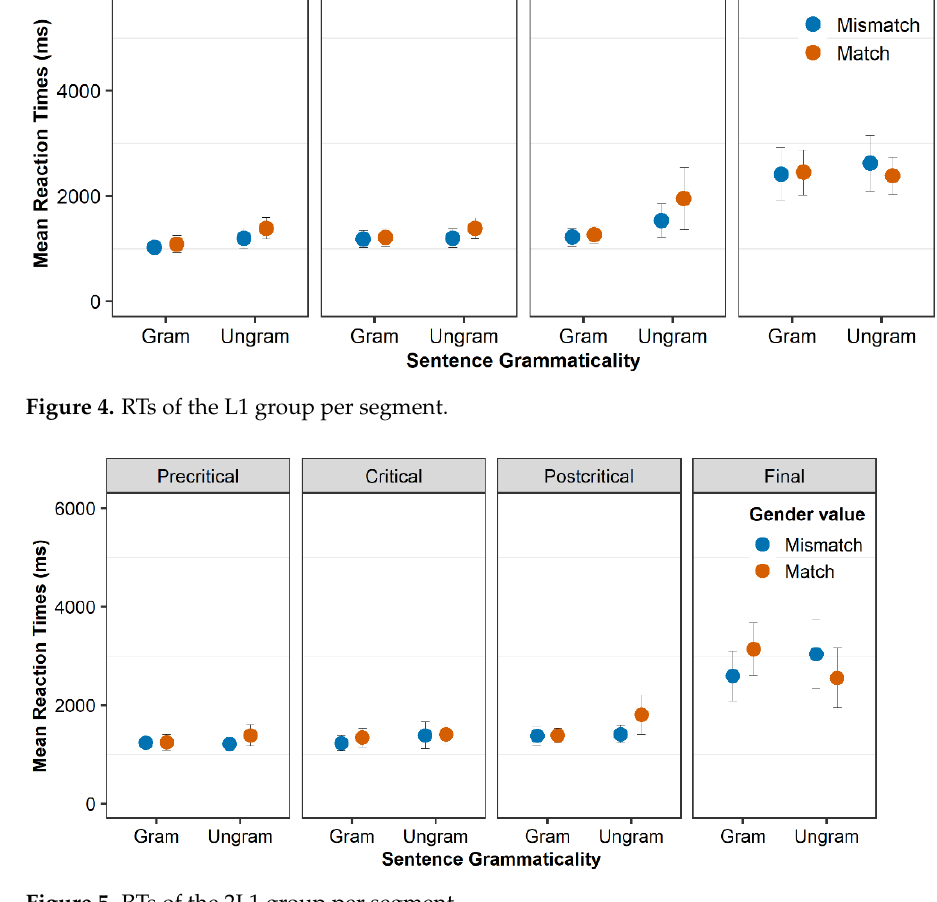
Figure 5. RTs of the 2L1 group per segment.